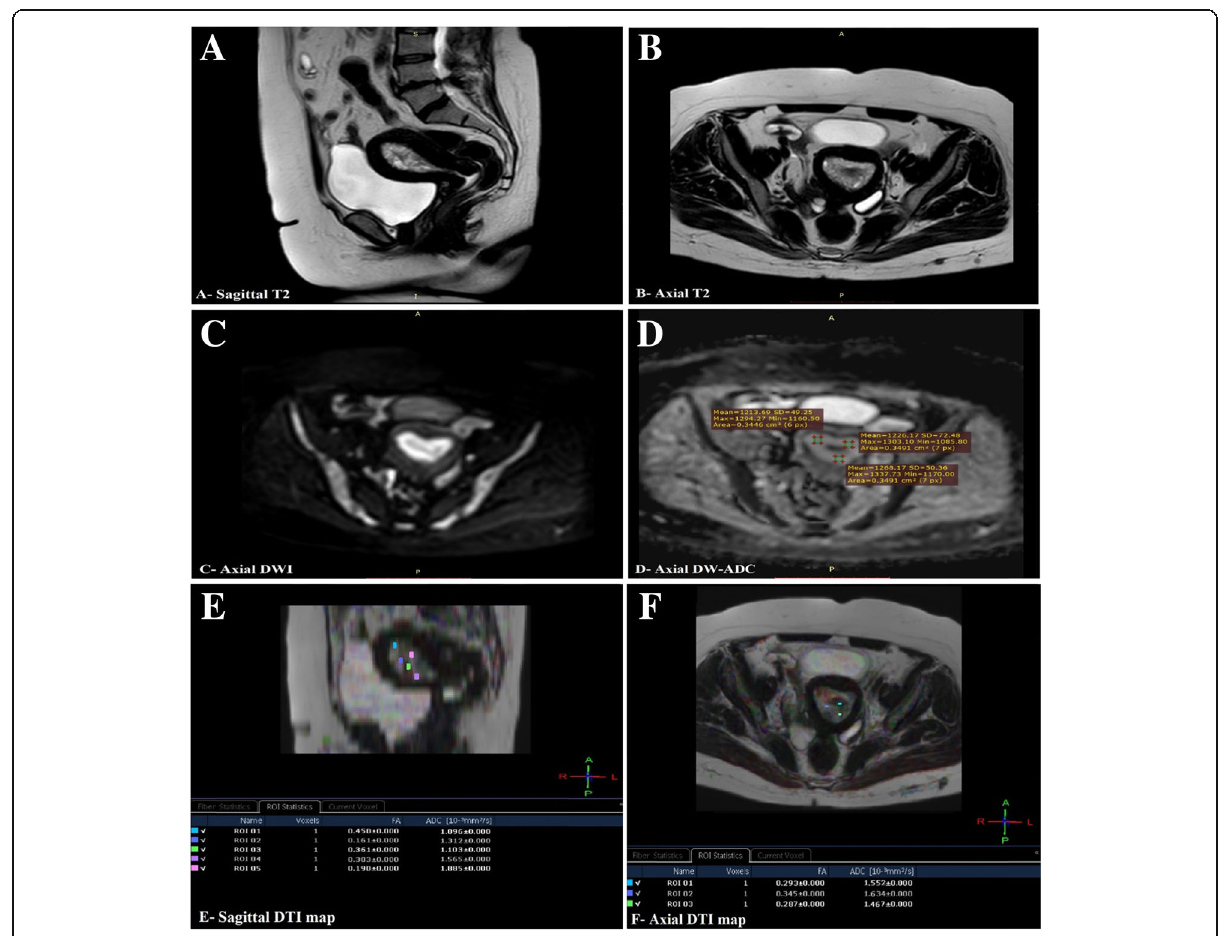
Fig. 4 A 45-year-old premenopausal female with history of breast cancer. The patient received tamoxifen therapy for 1 year. By TVS examination, the endometrium showed diffuse enlargement, measuring about 20 mm in diameter at the fundus with variable sized cystic changes inside. a, b Sagittal and axial T2 WIs show enlarged endometrium with heterogeneous signal intensity (blue arrows) due to associated cystic changes, and prominent stromal proliferation. c Axial DWI with b value of 1000 s/mm 2 shows high signal intensity of the thickened endometrium with central areas of intermediate SI (red arrow). d Axial DW-ADC map image shows thickened endometrium with intermediate signal intensity. Mean DW- ADC value = 1.232 × 10 − 3 mm 2 /s. e, f Sagittal and axial DTI map images demonstrate values of DT-FA and DT-MD in multiple ROI along the thickened endometrium. Mean DT-FA value = 0.299, and mean DT-ADC (MD) value = 1.552 × 10 − 3 mm 2 /s. Diagnosis: Tamoxifen-induced endometrial